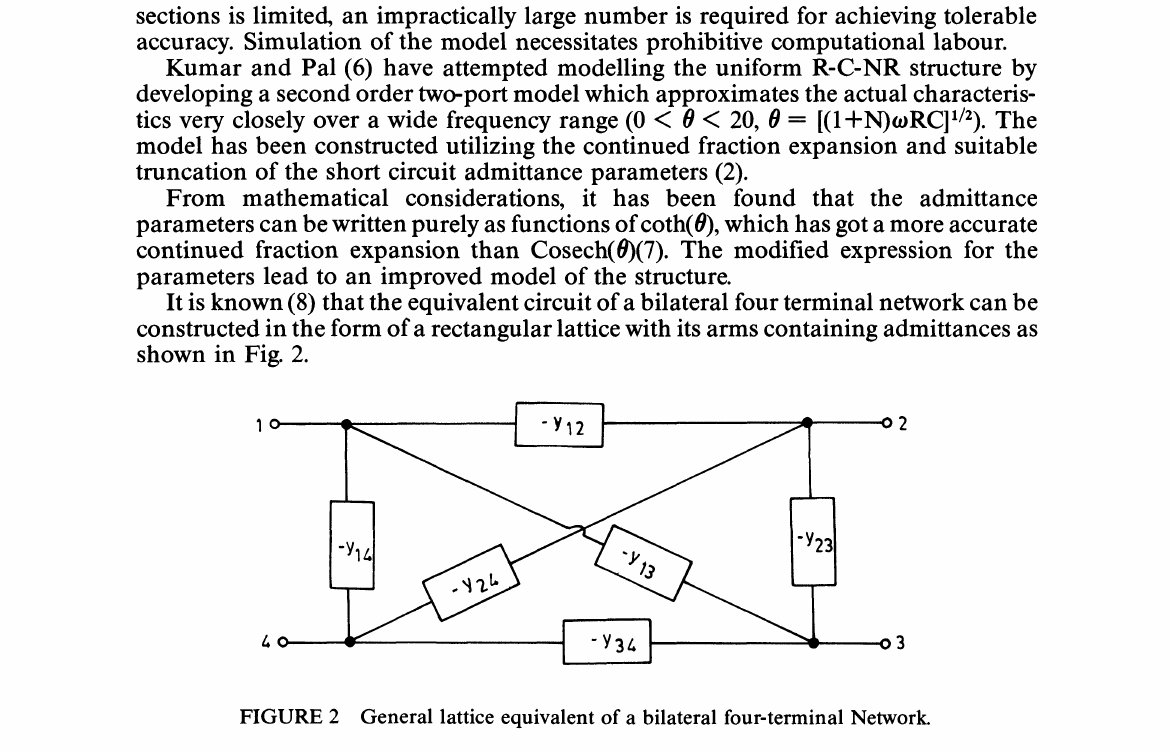
FIGURE 2 General lattice equivalent of a bilateral four-terminal